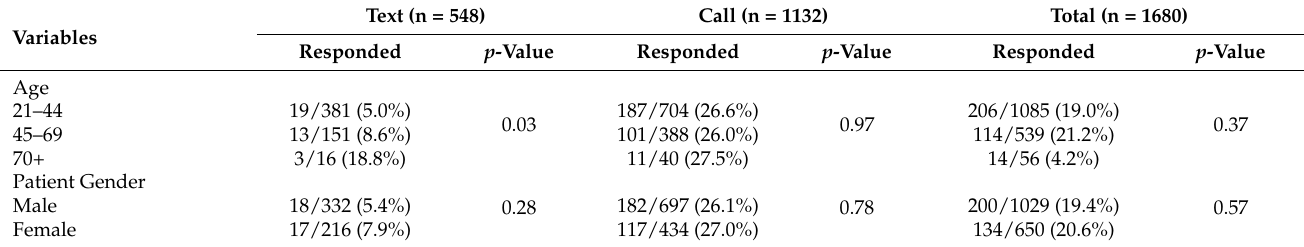
Table 2. Bivariate analyses of rates of response to recruitment requests by contact method a